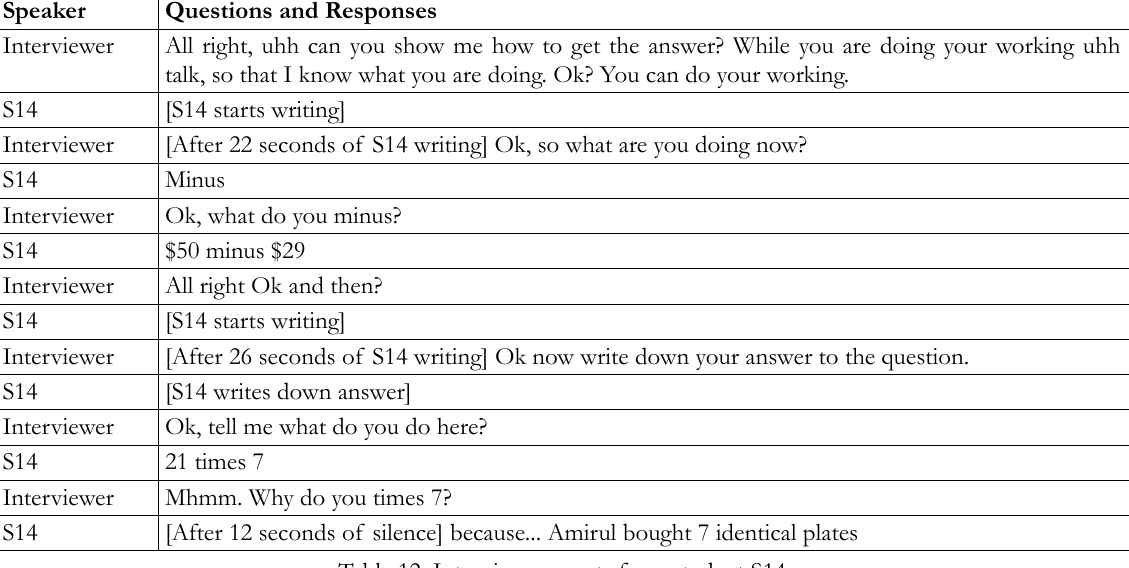
Table 12. Interview excerpts from student